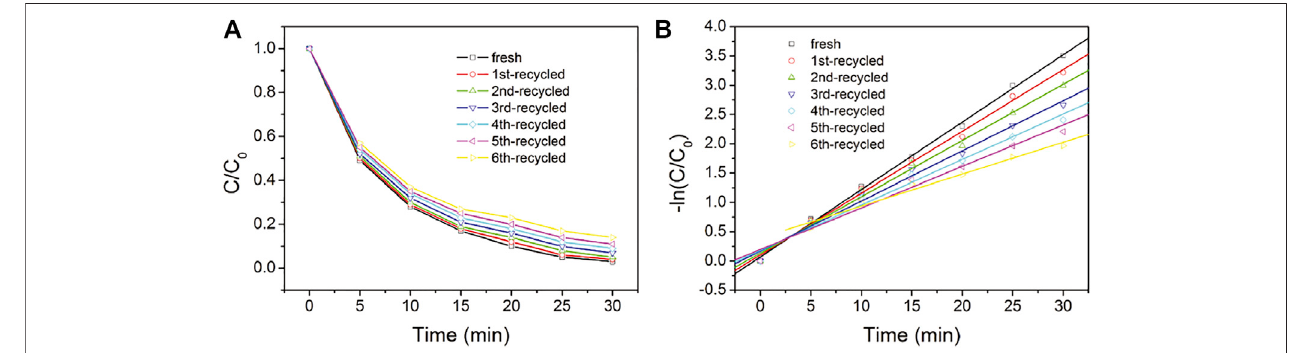
FIGURE 9 | XRD patterns of fresh NC2-4@SnS 2 and recycled NC2-4@ SnS 2 (after